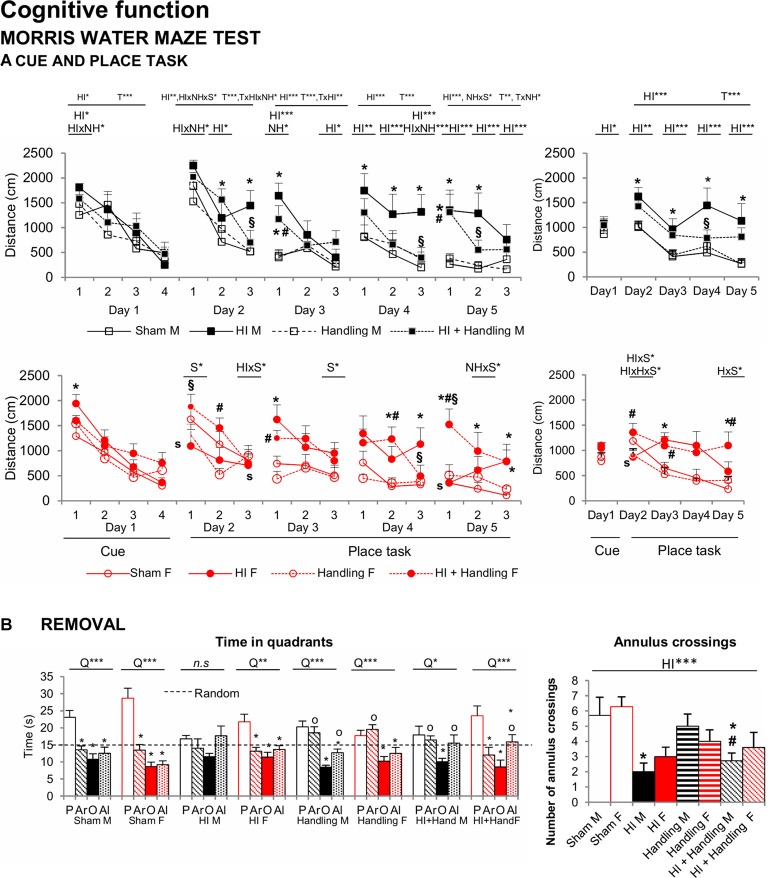
MWM: short- and long-effects of HI in males and females C57BL/6 and effects of NH. Cognitive functions were evaluated during PND70–PND90. Results are presented as mean ± SEM. Mean distance to reach the platform in the cue and place tasks for spatial learning. All days presented time effect. (A) Cognitive deficits were observed in the MWM in both sexes with reduced total learning capacities (acquisition of the task) and worse short and long-term learning. In HI mice a reduction of the mean distance covered to find the platform could be recorded in both “trial-by-trial” and “day-by-day”, especially in place tasks learning and were mainly important in HI males. Memory in HI males was more clearly affected than females in the MWM, however it was modulated by handling (B) In the probe trial for short-term memory, hypoxia males did not distinguish between the trained quadrant (P) and the adjacent (Ar, Al) or the opposed one (O) presenting a random swimming while handling (male and female) and HI + NH male presented a scanning swimming. Finally sham (male and female), HI and HI + NH female presented a focal searching swimming due they distinguish between the trained quadrant and the rest of the quadrants. The number of annulus crossings was also fewer in HI and HI + NH males. Statistics: Duncan’s post hoc test. *P < 0.05 vs. sham of the same sex; #P < 0.05 vs. handling of the same sex; §P < 0.05 vs. hypoxia of the same sex; sP < 0.05 female vs. male of the same treatment. Preference for the trained quadrant (P) as compared to adjacent right (Ar) and left (Al) or Opposite (O) quadrants in the probe trial. ANOVA, “Q” preference for trained quadrant. *P < 0.05, **P < 0.01, and ***P < 0.001; followed by Duncan’s post hoc test *P < 0.05 vs. P quadrant, oP < 0.05 vs. O quadrant. n.s. non-significant statistical differencs is found.